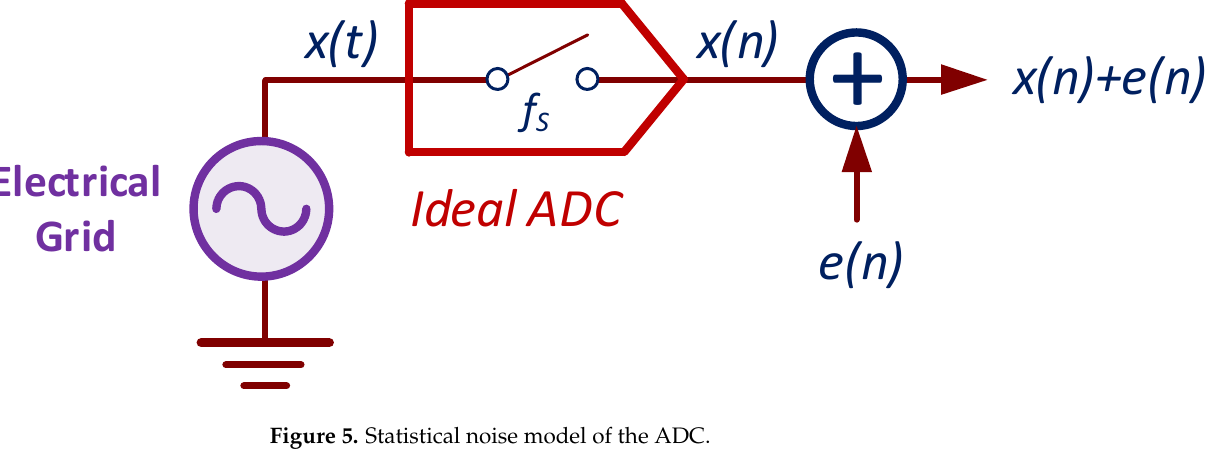
Figure 5. Statistical noise model of the ADC.